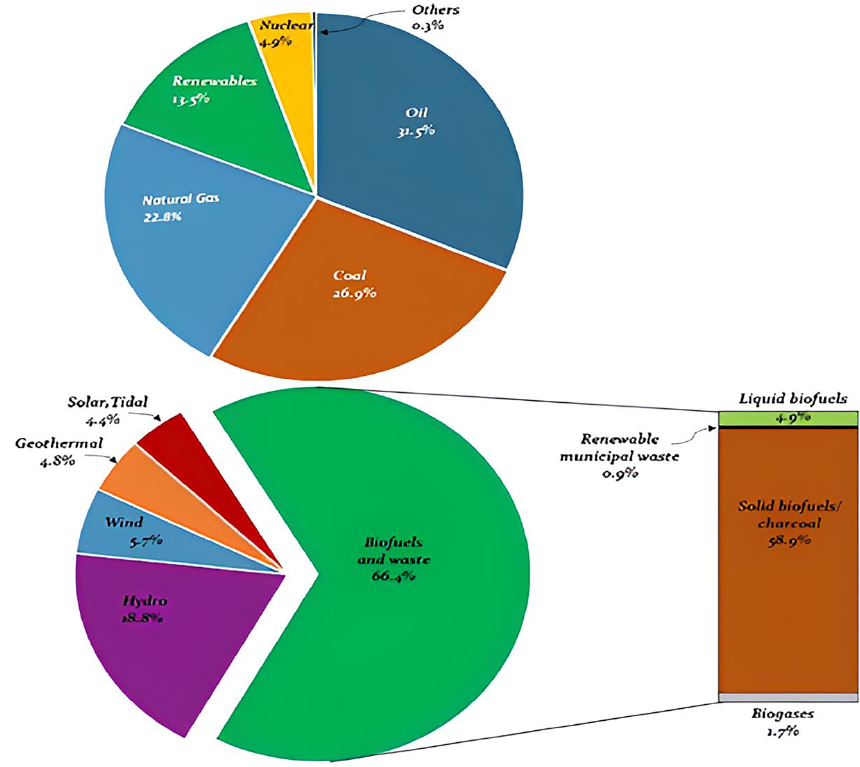
Figure 2. Distribution of global energy and renewable energy contribution [33].